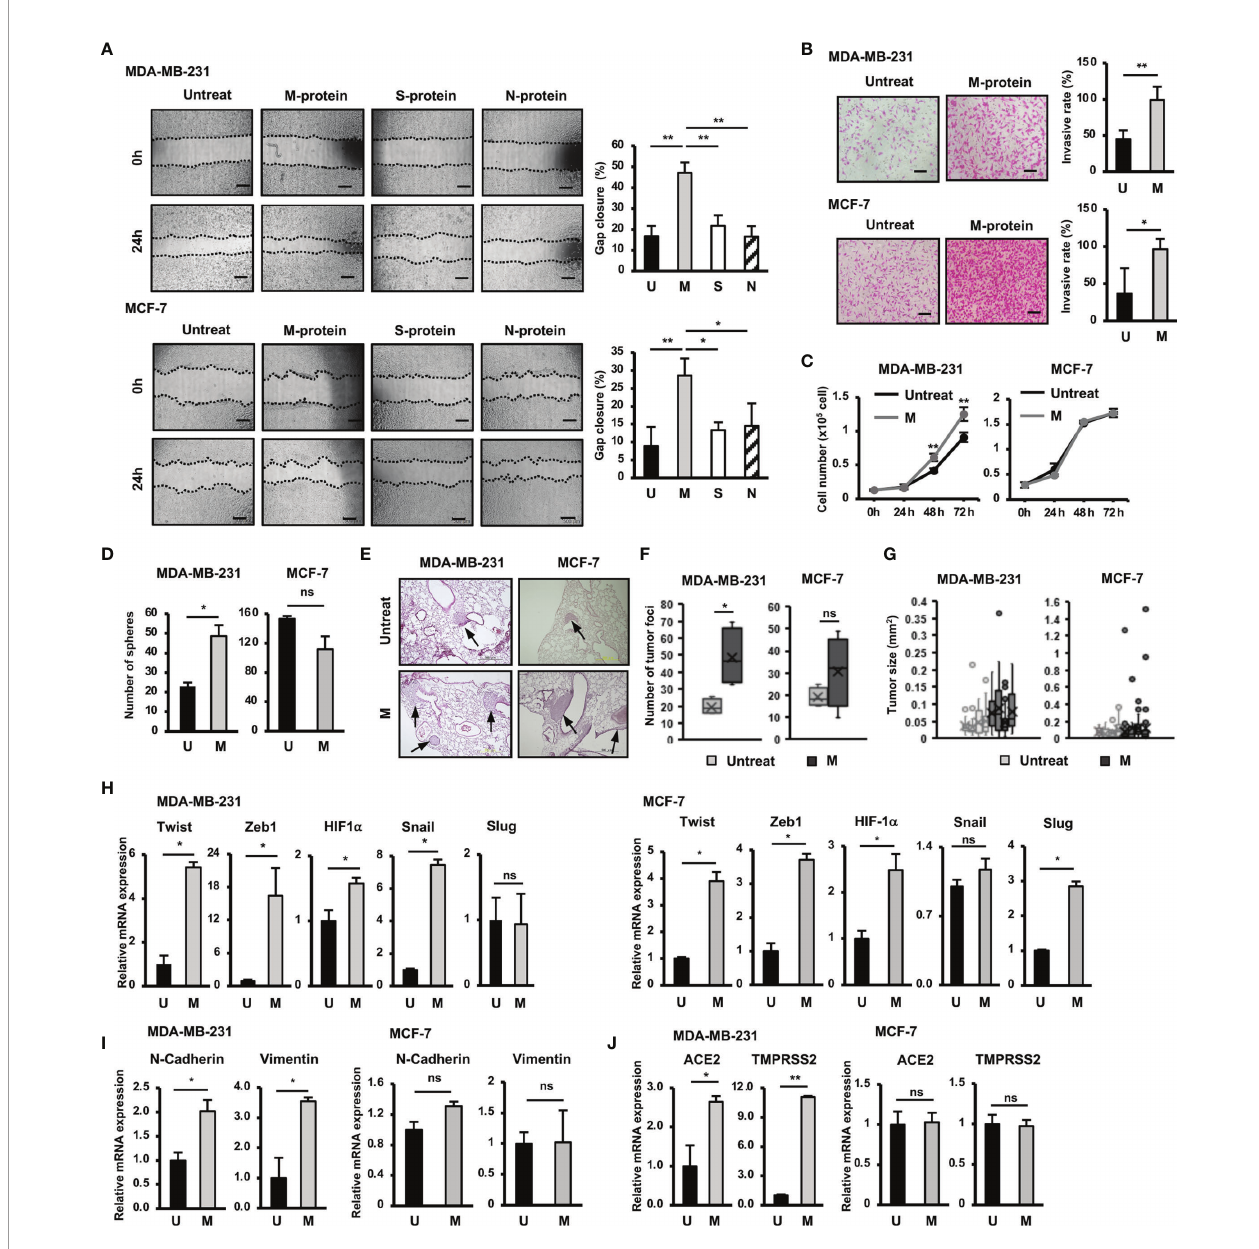
FIGURE 1 | Responses of BCC to SARS-CoV-2 protein. (A) The migration of BCC in response to SARS-CoV-2 proteins. (B) The BCC invasion assay in response to M protein. (C) The proliferation of BCC in response to M protein. (D) The mammosphere assay of BCC in response to M protein. (E) Lung sections from an in vivo metastasis assay of BCC, arrows indicate tumors in lungs. (F) Number of tumor foci from an in vivo metastasis assay. (G) Tumor sizes from an in vivo metastasis assay in individual mice; each dot indicates a tumor. (H) The mRNA expression of genes related to EMT process in BCC. (I) The mRNA expression of EMT markers in BCC. (J) The mRNA expression of SARS-CoV-2 binding receptor genes in BCC. U, untreated BCC; M, M protein-treated BCC. The scale bars indicate 500 µm. Each value represents the mean ± SD of triplicate experiments. (ns, no signi fi cance; p > 0.05; *p ≤ 0.05; **p ≤